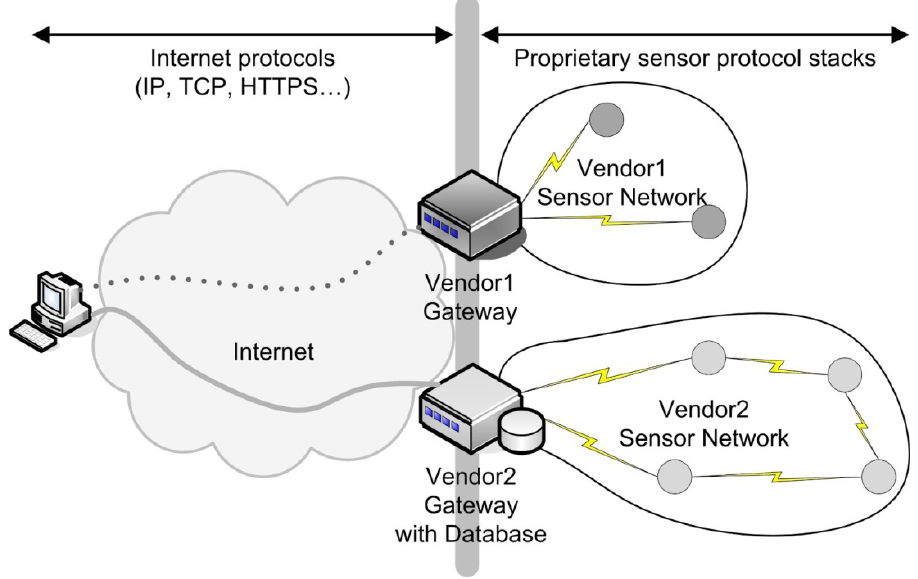
Figure 1. Gateways and proprietary protocols are often used to interconnect sensor networks to the Internet.